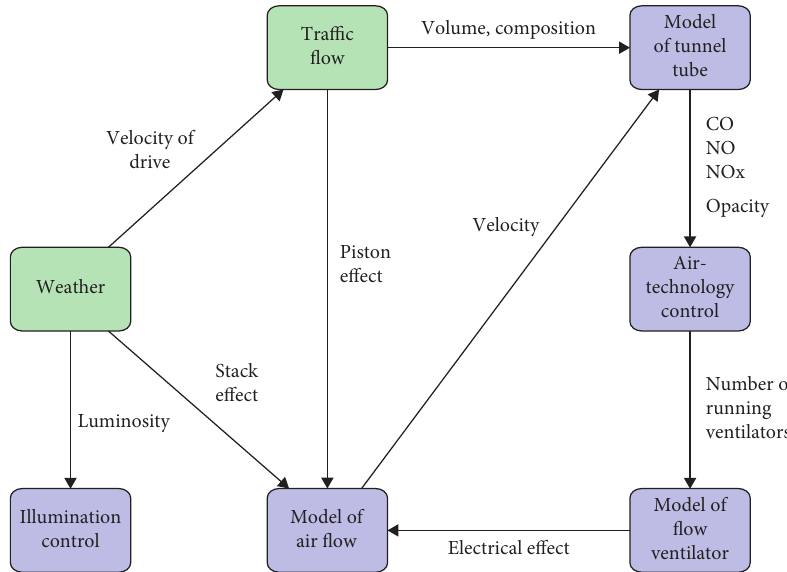
Figure 3: Interactions among modules of the extended simulation model TuSim.